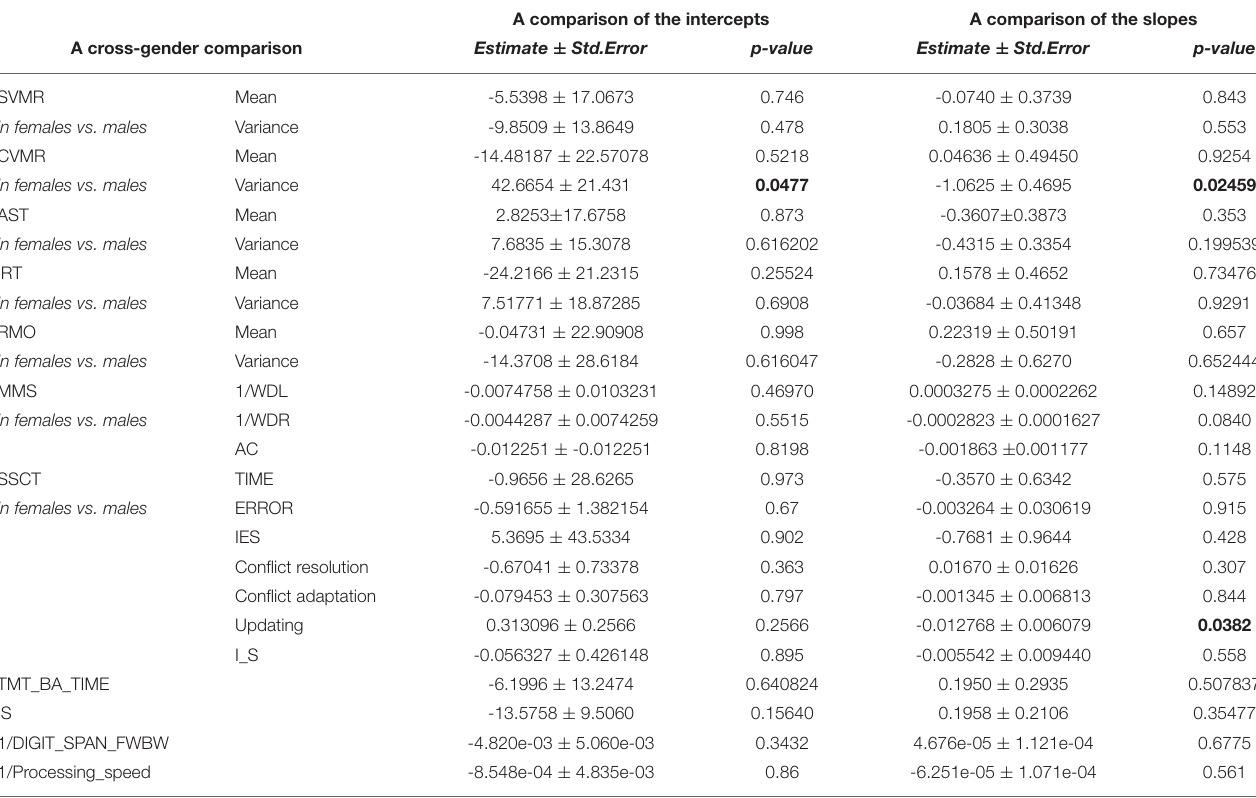
TABLE 5 | Interaction coefficients for the comparison of intercepts and slopes for the psychophysiological outcomes of brain atrophy and Stroop switching card test datasets. A comparison of the intercepts